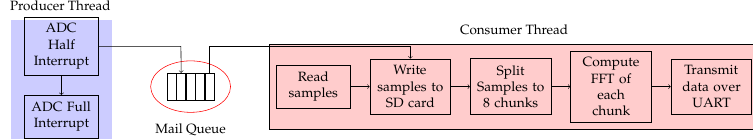
Figure 3. Software flowchart for the firmware present on the